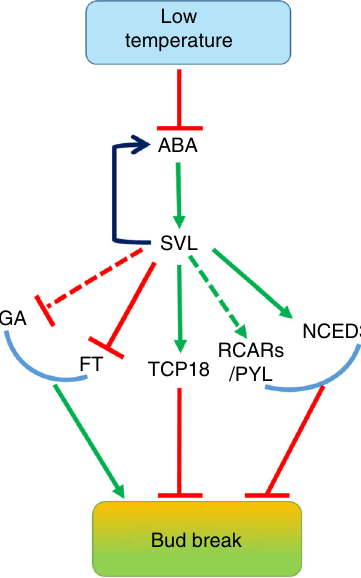
Fig. 7 Hypothetical model integrating components involved in bud